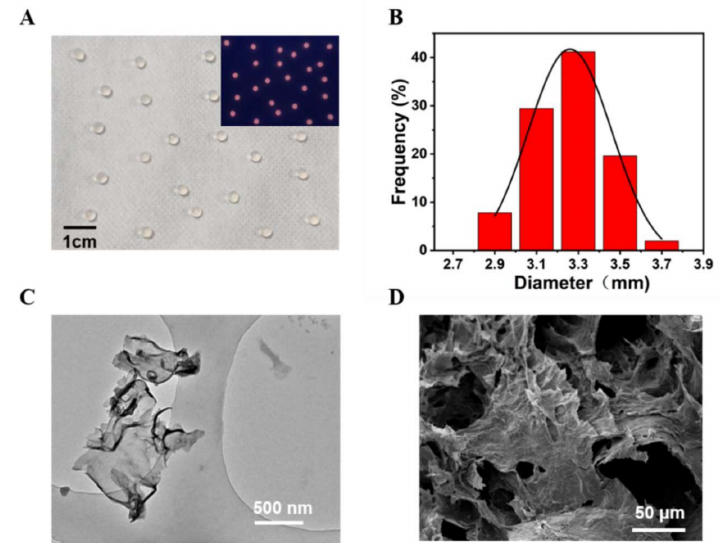
Figure 4. Characterization of Alg@PDCN@QDs-LOx MSs. ( A ) Picture of microspheres under natural light. Inset: Under a UV lamp, a photograph of microspheres. ( B ) The diameter distribution diagram of microspheres. ( C ) TEM image of the PDCN nanosheets. ( D ) SEM image of the